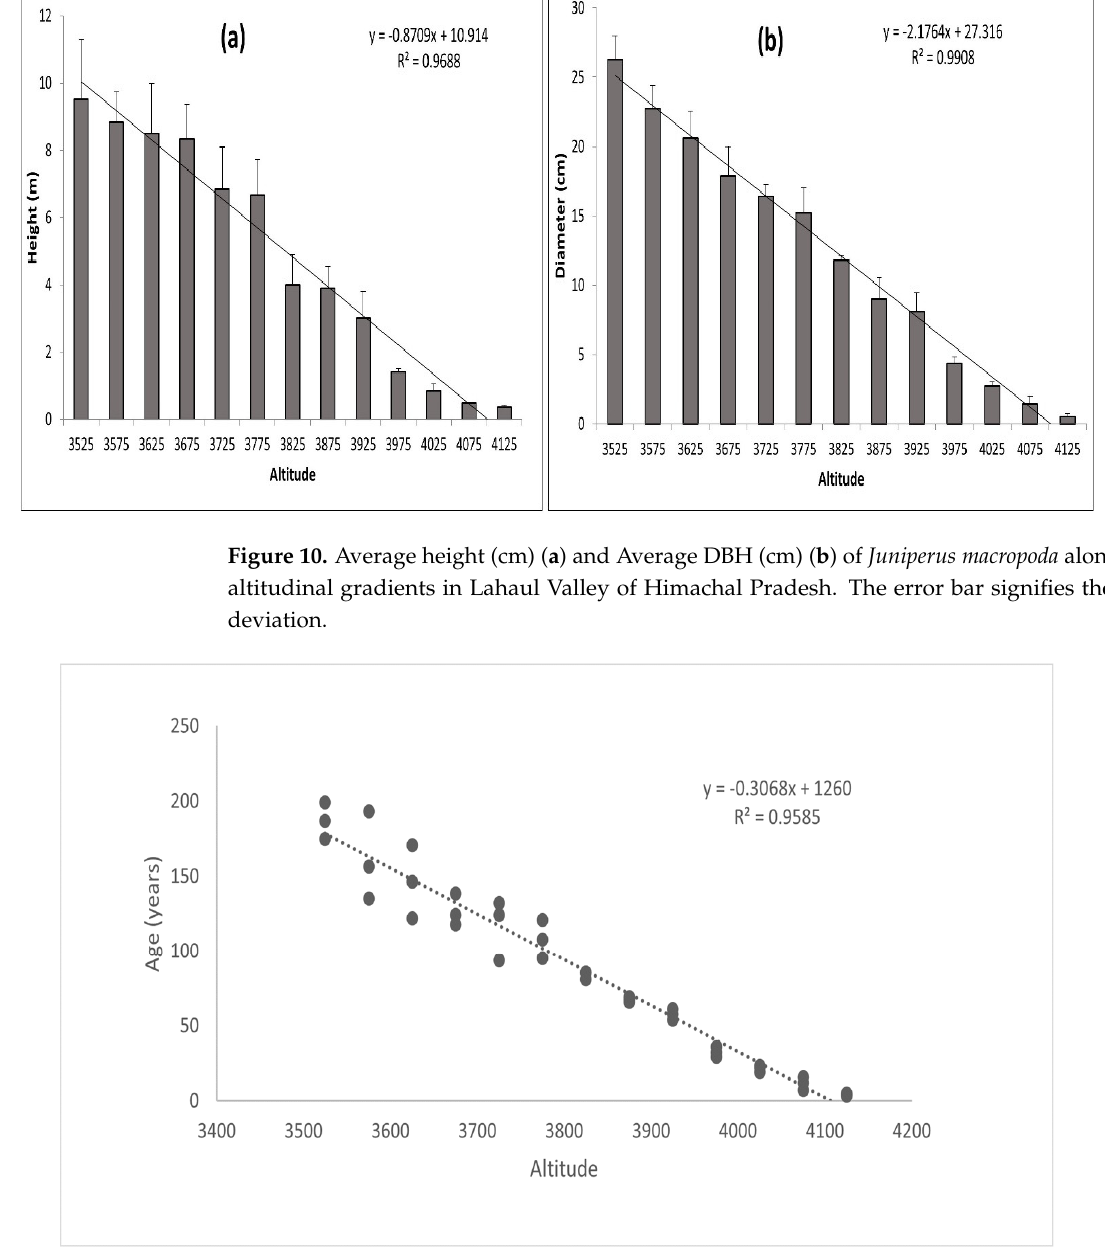
Figure 11. Age of Juniperus macropoda along different altitudinal gradients in Lahaul Valley of Hi- machal Pradesh. Table 2. Rate of shift of Junipers macropoda in Lahaul Valley of Himachal Pradesh.